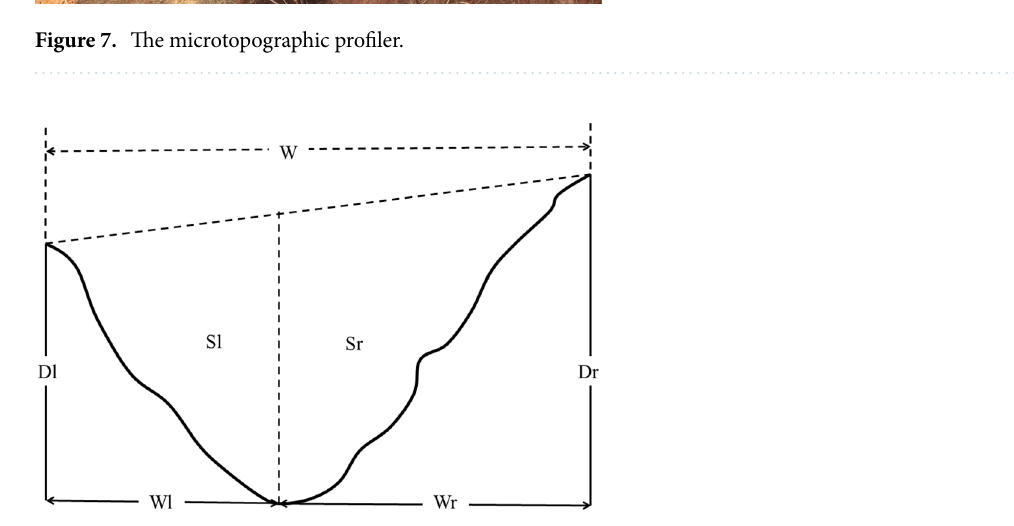
Figure 8. Schematic diagram of cross-sectional